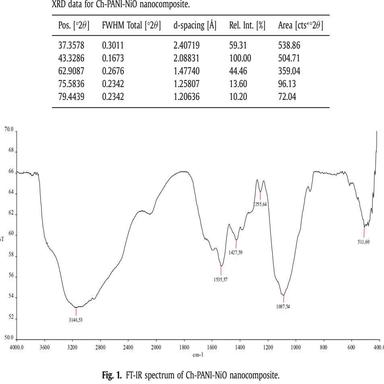
X-ray diffractogram of Ch-PANI-NiO nanocomposite.